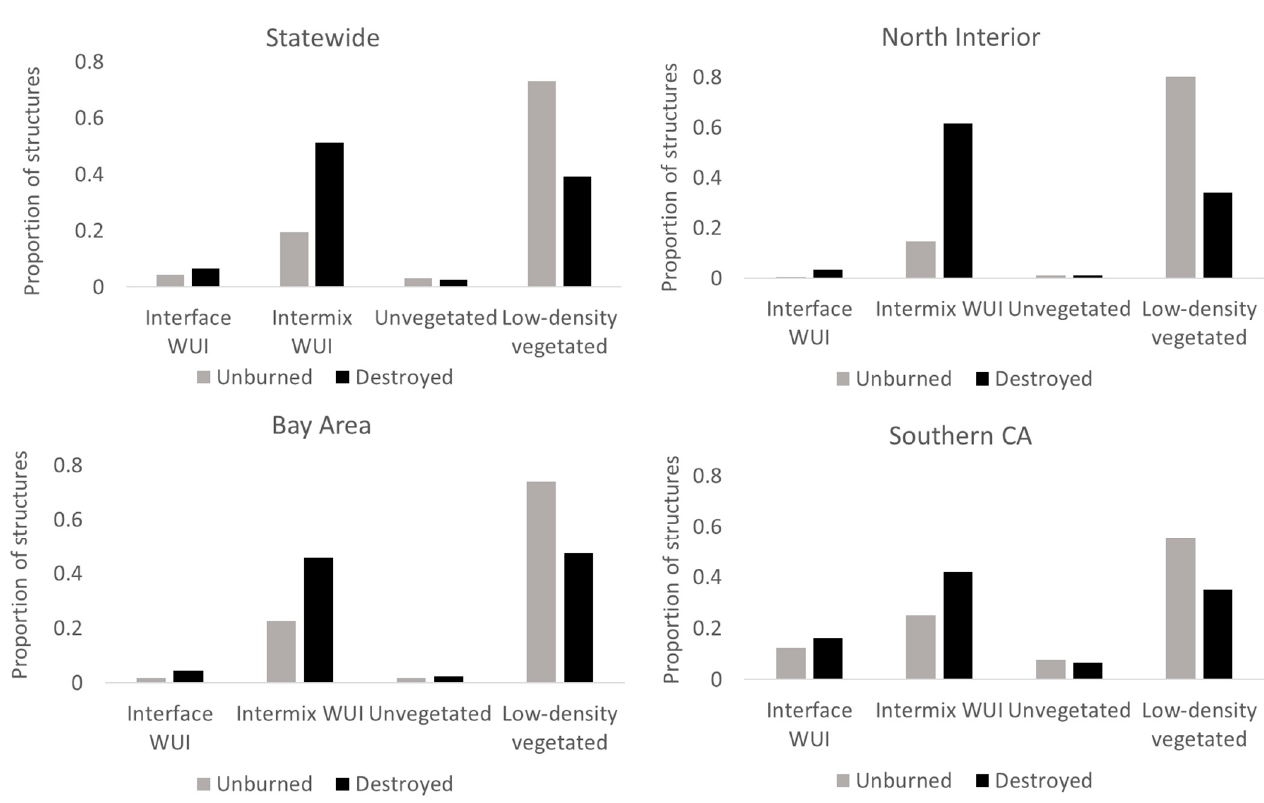
Figure 4. Proportion of unburned and destroyed structures distributed among four Wildland–Urban Interface cover classes statewide and in three regions of California. Table 2. Relative risk (RR) among WUI classes statewide and for three California regions. In the class comparisons, an RR > 1 means the first class listed had disproportionately more destroyed than unburned structures; < 1 means the first class listed had disproportionately fewer destroyed than unburned structures; and 1 means no difference between the two classes.